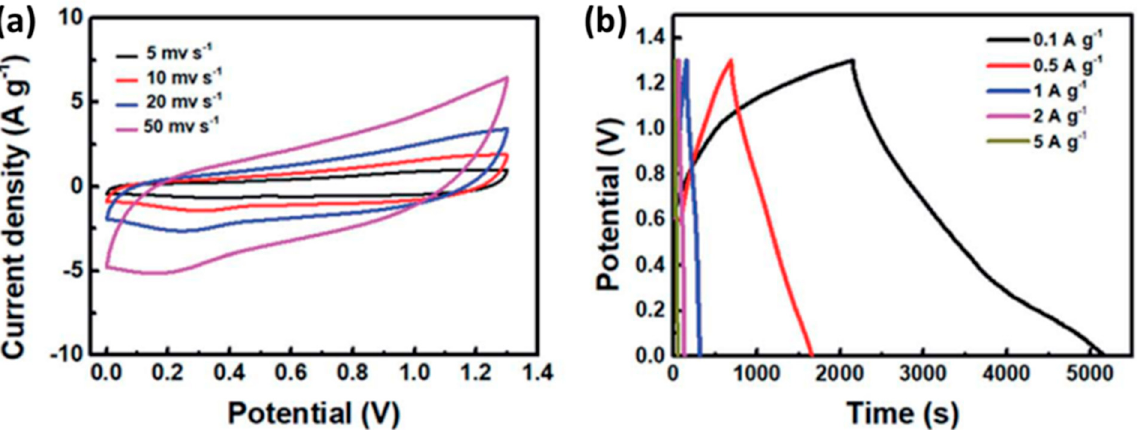
Figure 23. ( a ) CV plots of the asymmetric capacitor at different scan rates. ( b ) GCD plots for GQD/MnCo 2 O 4.5 /rGO supercapacitor at different current densities. Reprinted with permission from Ref. [182]. Table 3. Electrochemical performances of the GQD-based supercapacitor